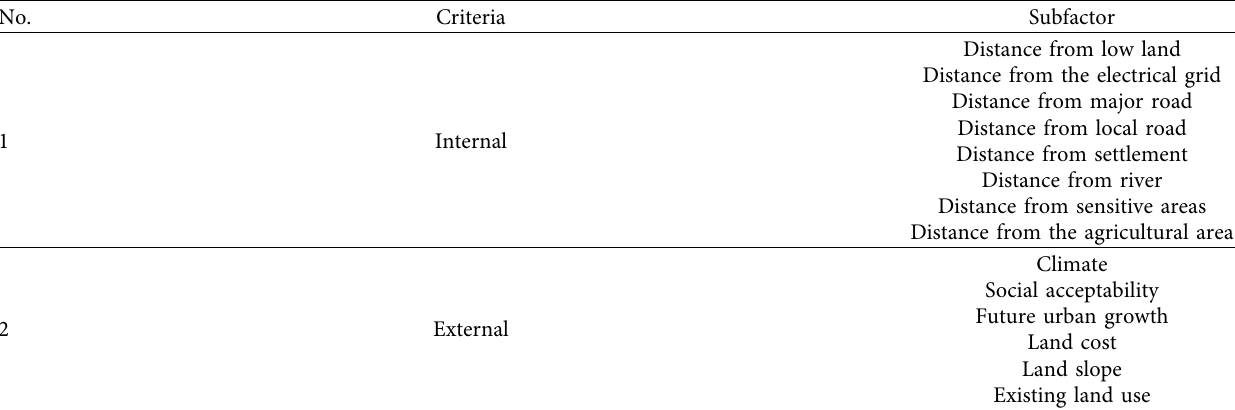
Table 10: The classification of subfactors into internal or external criteria based on SWOT analysis.